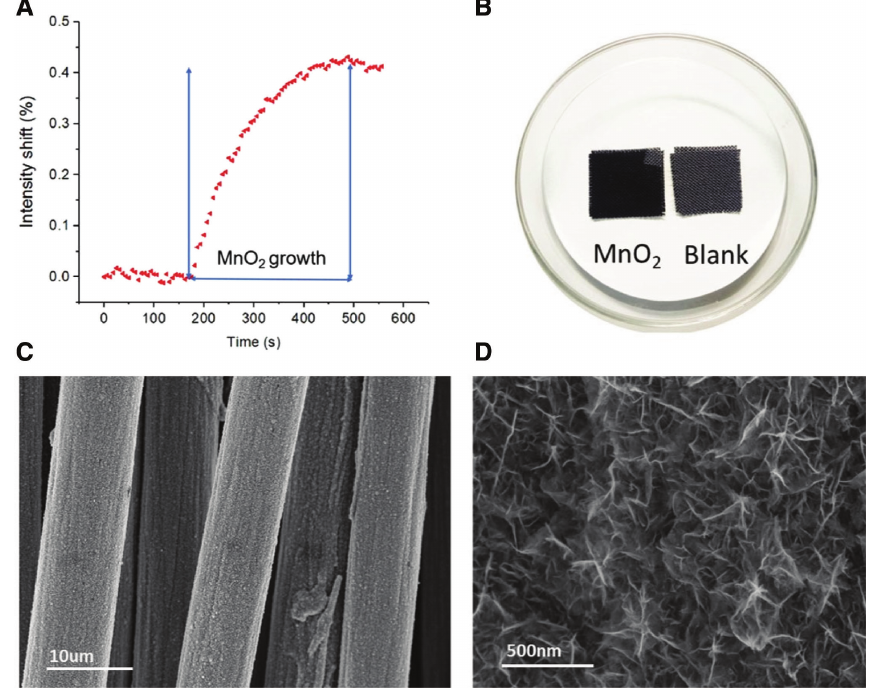
growth on carbon fabric. Figure 4: MnO 2 (A) On-line monitoring MnO growth process on carbon fabric by fiber-optic LSPR sensor (B) MnO 2 fabric (right). (C) SEM image of MnO on carbon fabric. (D) Magnified SEM image of MnO 2 loaded with MnO demonstrates a black color, while the 2 blank carbon fabric is gray. The electrode with MnO darker. Figure 4C and D is the SEM image of the surface of